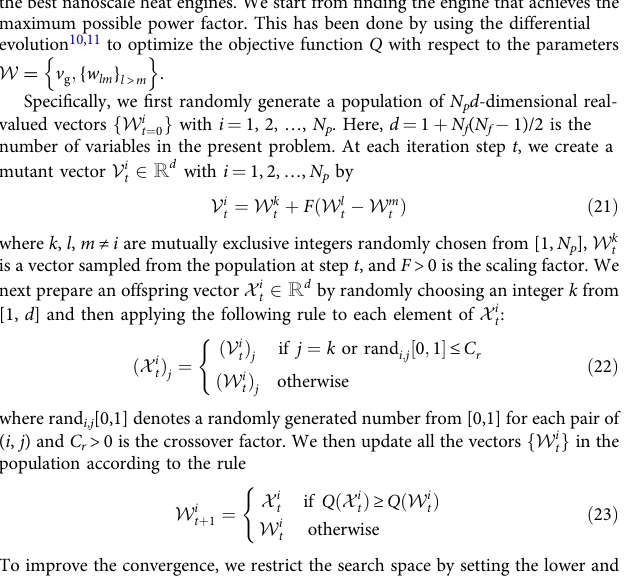
ffiffiffi p P . We use the multilevel setting with the